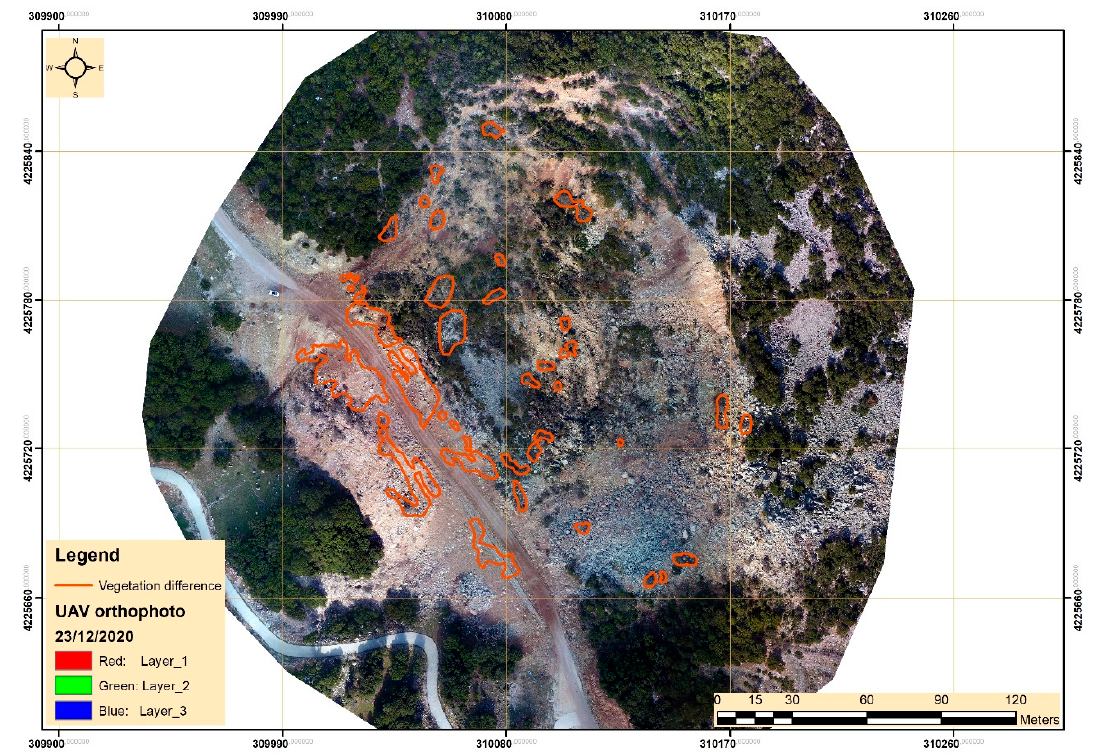
Figure 16. Digitized vegetation differences between 2017 and 2020.